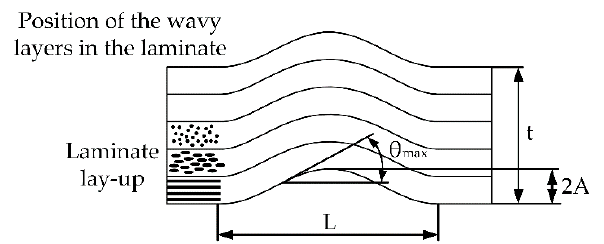
Figure 2. Parameters influencing the mechanical properties (e.g., amplitude A, wavelength L, laminate thickness t, maximum fiber misalignment angle θ max , layup, and the position of wavy layers within the laminate).